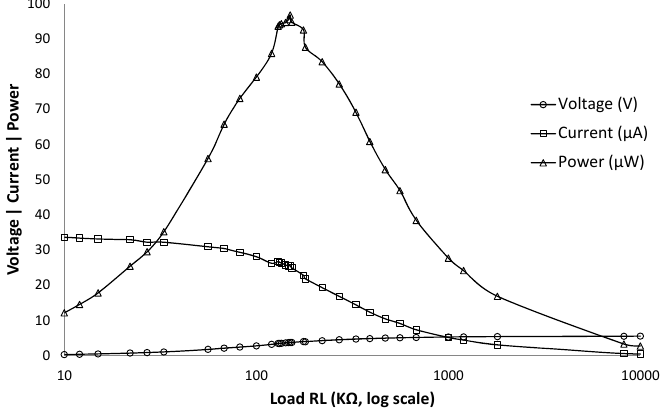
Figure 3. Current, voltage and power characteristics of indoor solar panel evaluated for different resistor values.